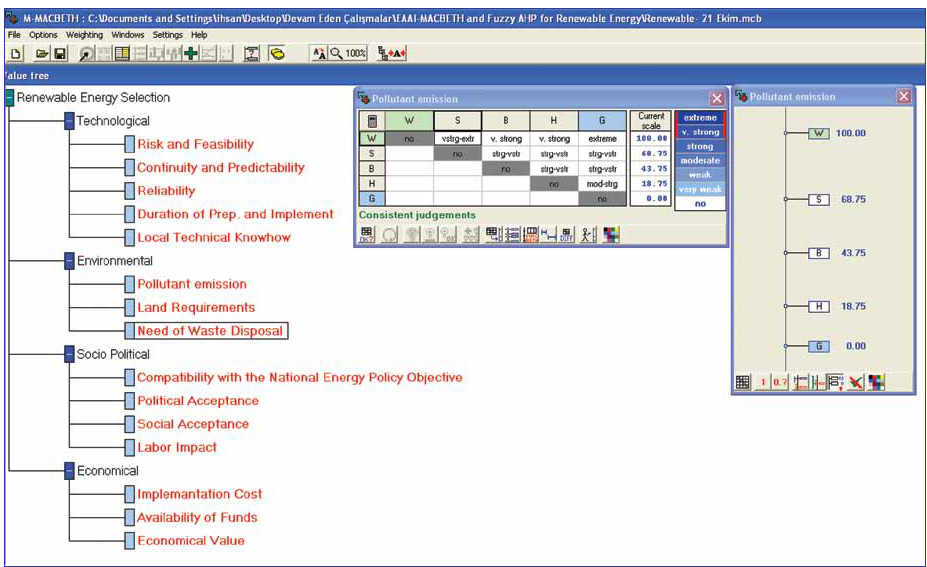
Fig. 5. The ranking result with respect to “Pollutant